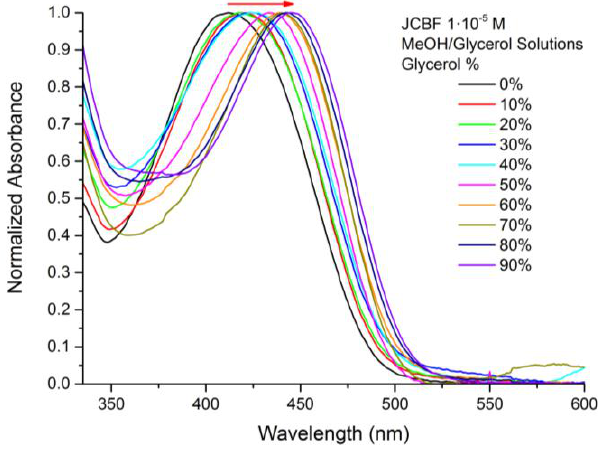
Figure 1. UV-Vis absorption spectra of 1 × 10 −5 M JCBF in methanol/glycerol solutions with different glycerol volume contents. Table 2. Optical features of 5 × 10 −6 M JCBF solutions.